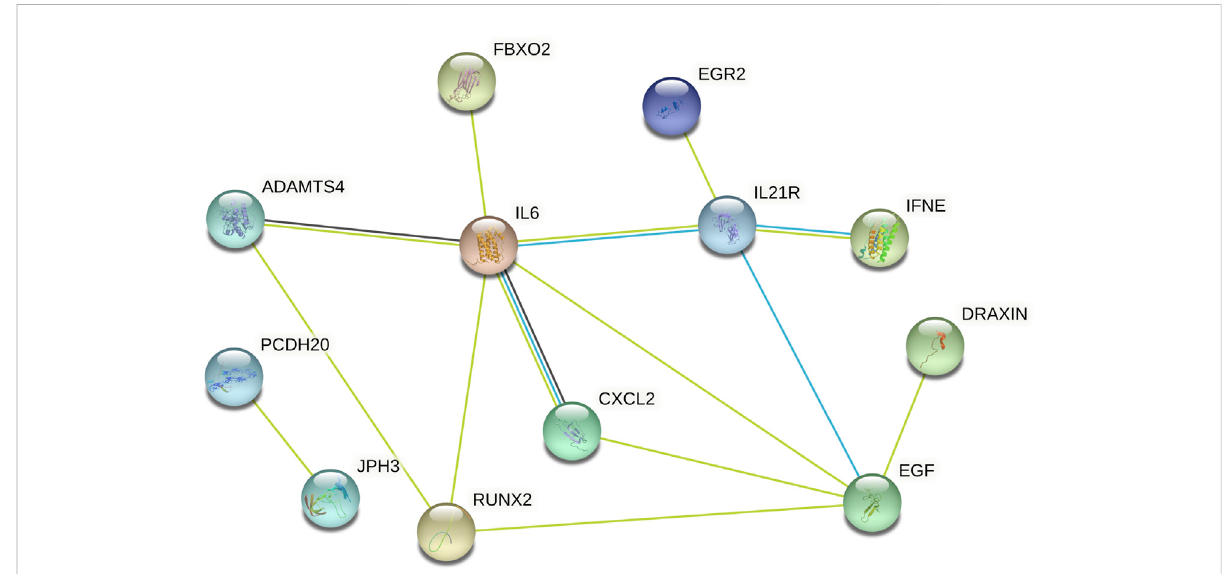
FIGURE 5 The PPI Among 37 Differentially Expressed Genes. PPI = protein-protein interactions.